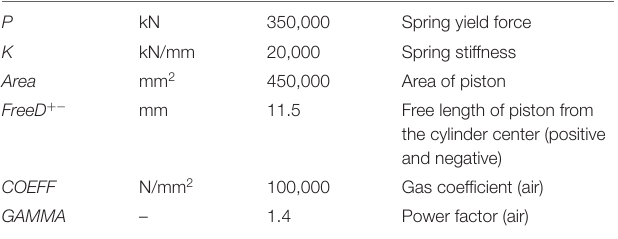
TABLE 2 | Parameters of the semi-active spring model for infill with sliding joints of the University of Pavia.